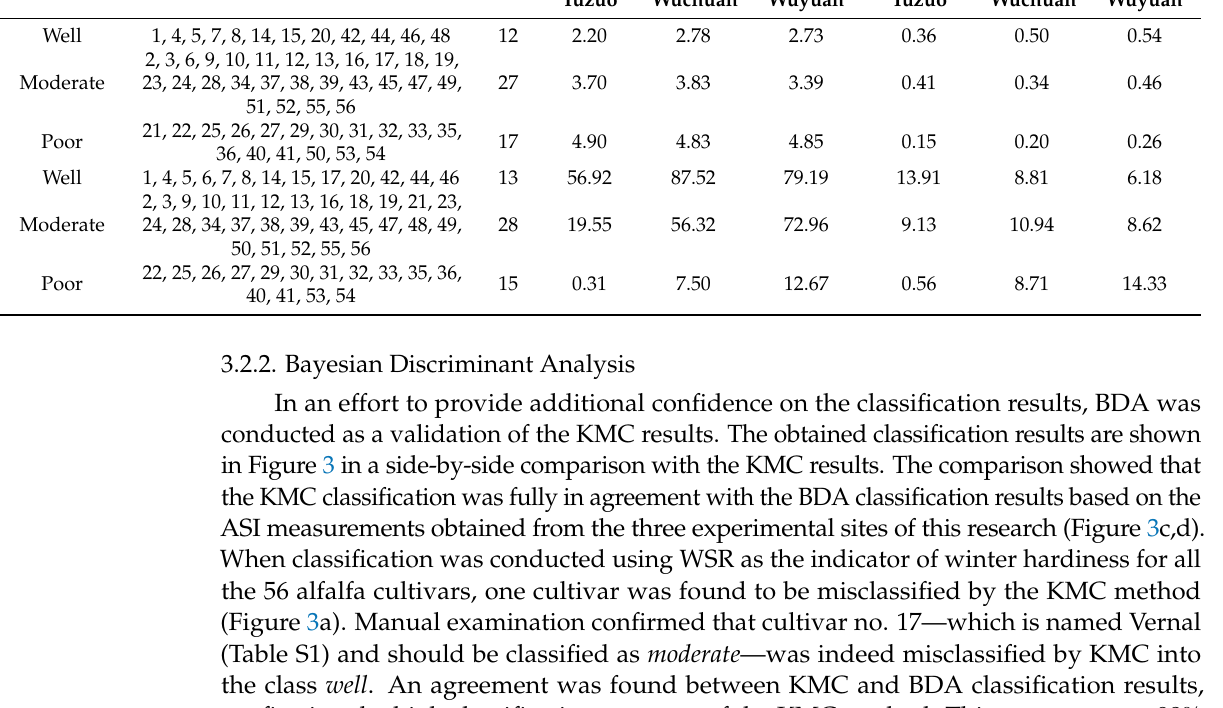
Table 6. Winter hardiness classification of 56 alfalfa cultivars by K-means clustering.